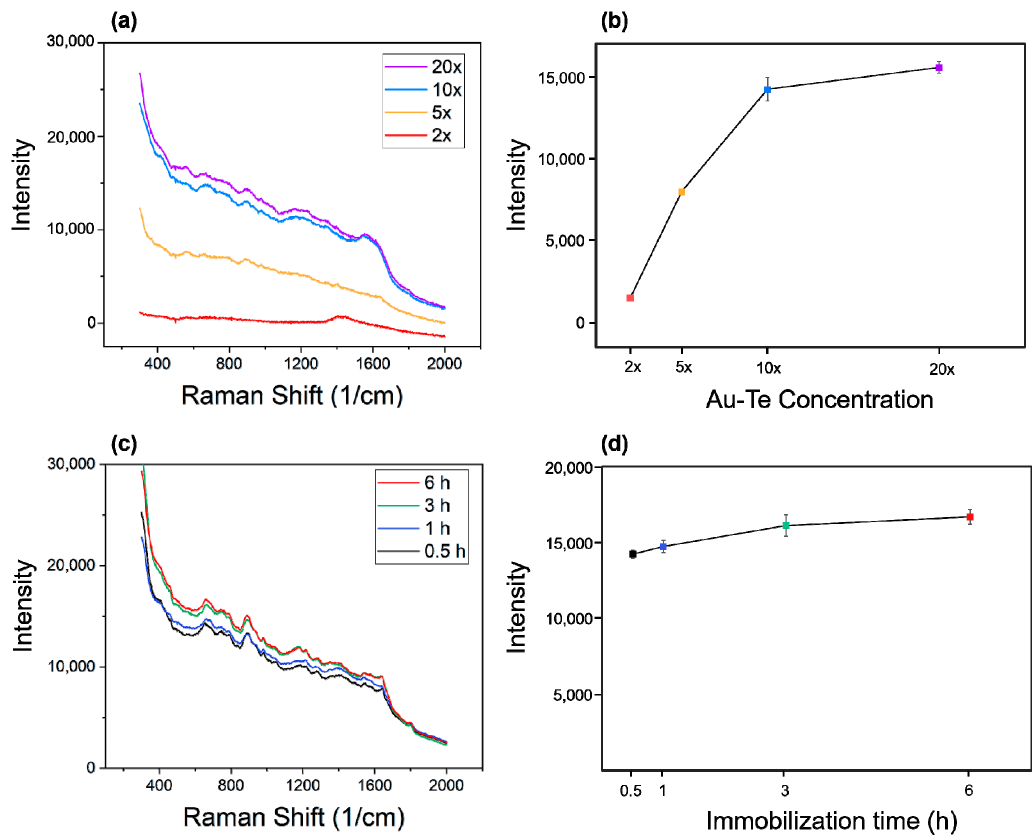
Figure 4. Optimum conditions for Au–Te immobilization on ITO. ( a ) Raman spectra of various Au–Te concentrations on an ITO substrate, ( b ) the SERS effect of Au–Te concentrations, ( c ) Raman spectra with different immobilization time conditions of Au–Te on ITO, ( d ) the SERS effect of Au–Te immobilization time.